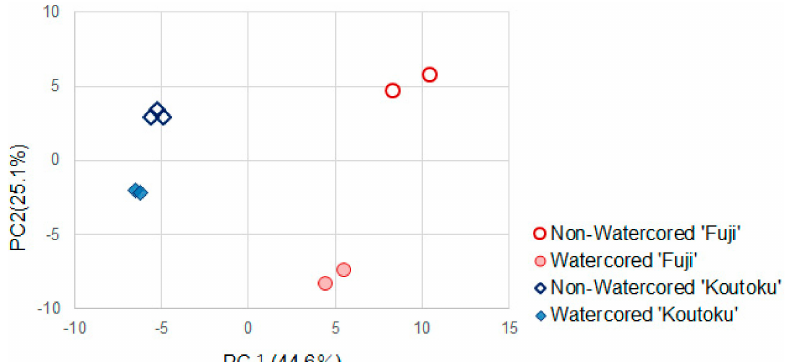
Figure 1. Principal component analysis score plots of the volatiles and solubles of fruit juice. PC1 and PC2 scores were discriminated by cultivars and watercore existence, respectively. Top 10 of PC2 loadings were (1) ethyl butanoate, (2) ethyl propanoate, (3) ethyl 2-methylbutanoate, (4) ethyl acetate, (5) ethyl hexanoate, (6) sorbitol, (7) galactaric acid, (8) methyl 2-methylbutanoate, (9) methyl acetate, and (10) ethyl tiglate. Reproduced with permission from Tanaka et al. [13].